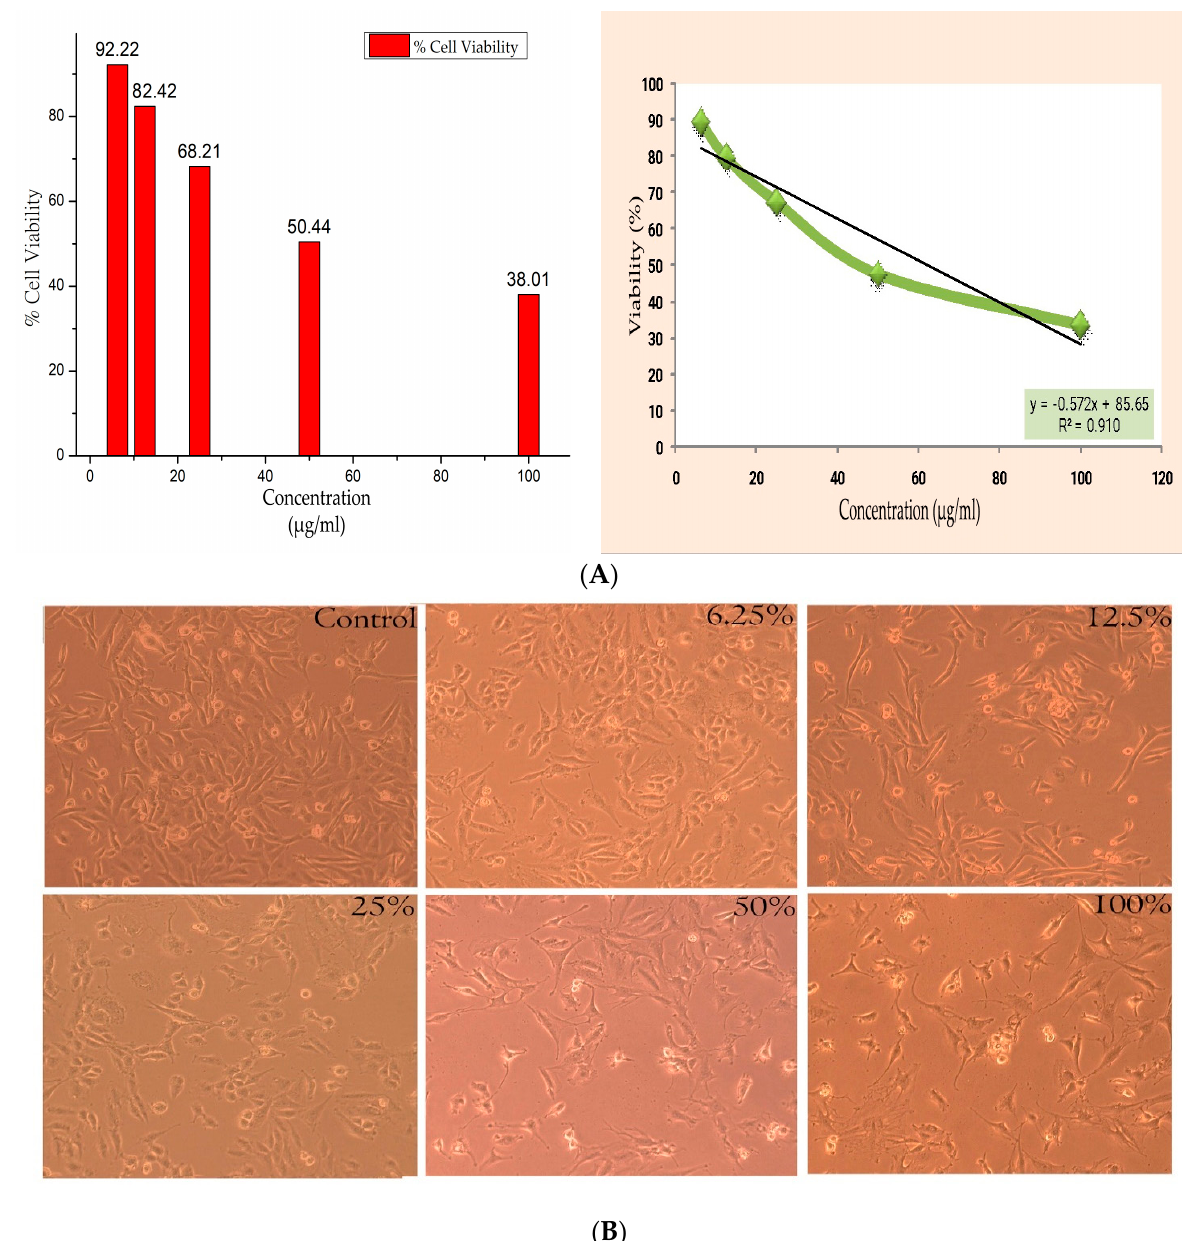
Figure 5 . ( A ) Cell viability % of samples with different concentration and line graph of viability % with concentration by using equation y = mx + c. ( B ) MTT optical microscopy images of SKMEL-26 cancer cell growth after 48 h culturing in presence of the film. Cell viability % with concentrations of 6.25, 12.5, 25, 50, and 100 µg/mL.